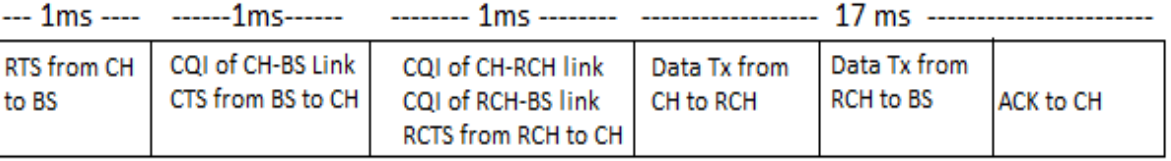
Figure 7. Cluster head cooperative transmission session.